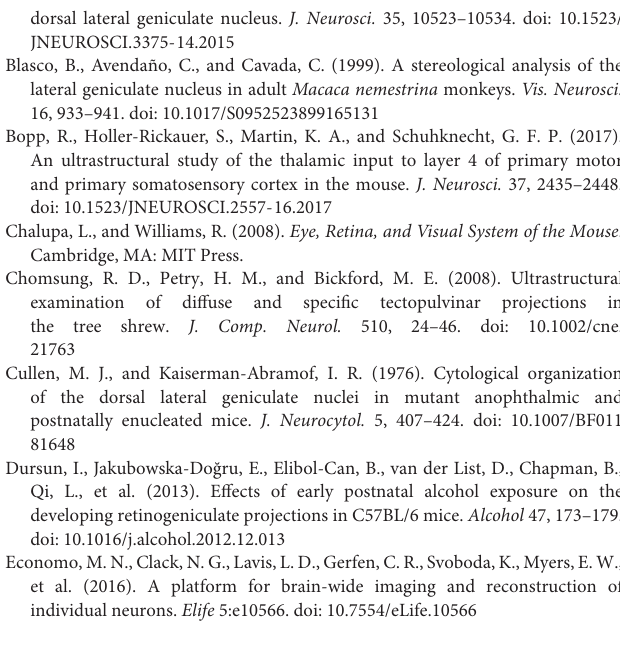
FIGURE S1 | Stereological methods used for estimating volume (A,B) and neuron number (C,D) in dLGN and LP complex on Nissl-stained coronal sections. (A,B) Delimitation of dLGN (red) and LP complex (blue). An ideal counting frame is shown in each section where it is identified the exclusion (red) and inclusion (green) borders. In (A) is also shown the point grid (green) used to estimate the nuclear volume with the Cavalieri method. (C,D) Representative microphotographs of coronal section showing a representative unbiased counting frame. Neurons (red arrows) are identified by their darkly stained nucleolus in a lighter stained nucleus and their large size; glial cells (green arrows) are much smaller, have multiple nucleoli and no visible cytoplasm; endothelial cells (blue arrows) have a curved elongated shape and usually no visible nucleolus. Scale bars A, B = 100 µ m; C, D = 10 µ m. FIGURE S2 | Complete penetration of the GABA antibody in the tissue sections. (A–C) Examples of neurons immunostained for GABA. The soma of these neurons was located in the center of the sections ( z = 6–8 µ m on the dried, mounted sections). TABLE S1 | Total neuron number estimations in visual thalamic nuclei. TABLE S2 | Volume estimations of the visual thalamic nuclei (in mm 3 ) and interhemispheric differences, (in mm 3 ). TABLE S3 | Number of GABAergic interneurons in visual thalamic